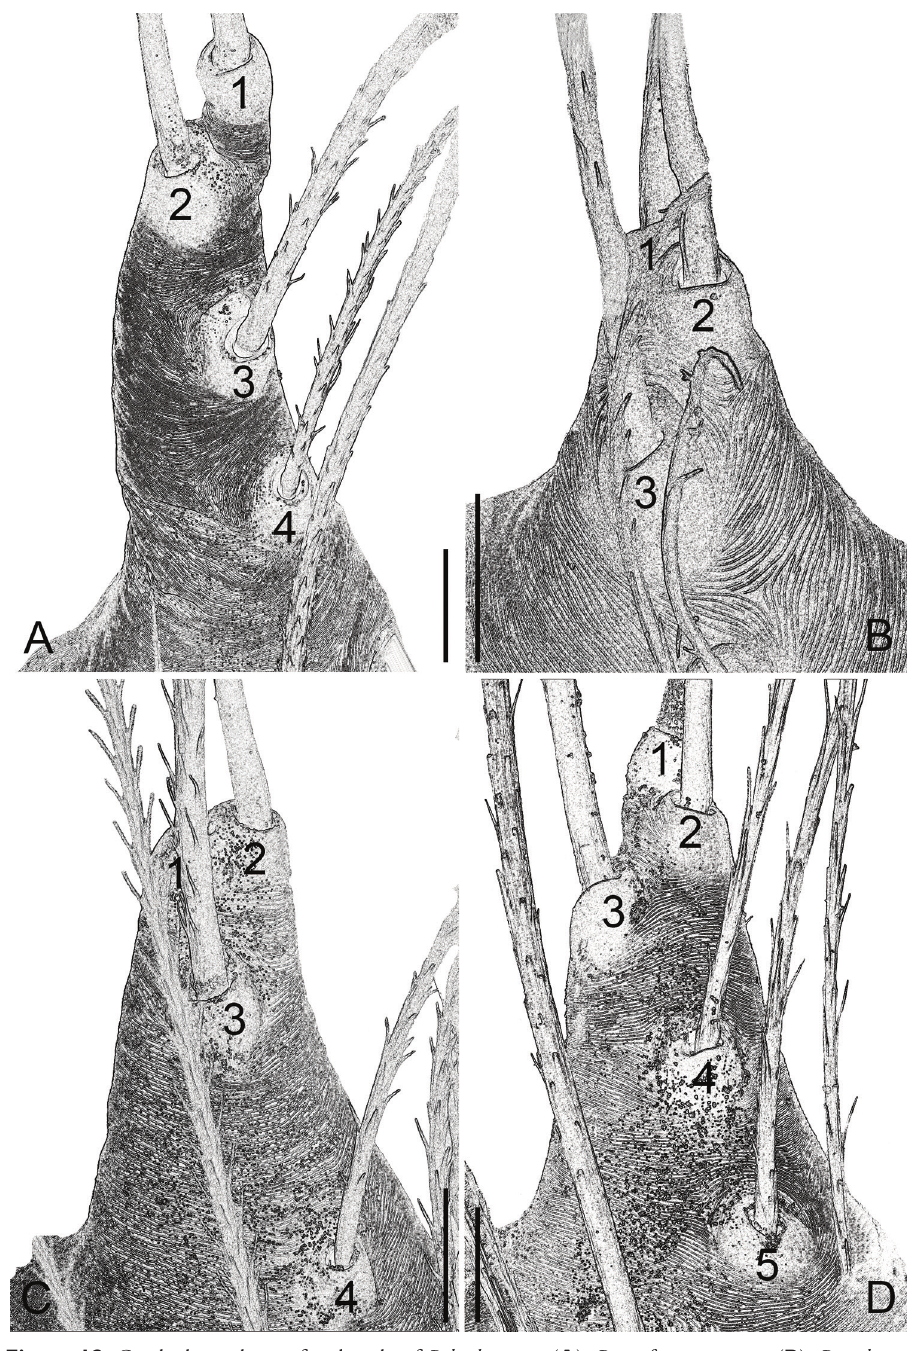
Figure 12. Cymbial apophysis of male palp of P. bailongensis ( A ); P. cunfengensis sp. n. ( B ); P. podiensis sp. n. ( C ); P. qingfengensis sp. n. ( D ). Scale bars: 0.01 mm. Arabic numerals refer to 1 st –5 th setae. First seta in P. podiensis sp. n. is